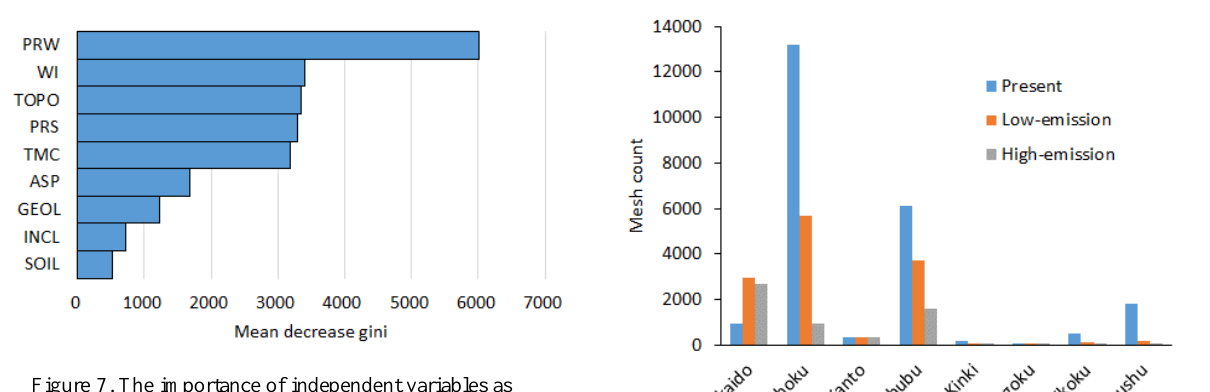
Figure 7. The importance of independent variables as determined by MDG.